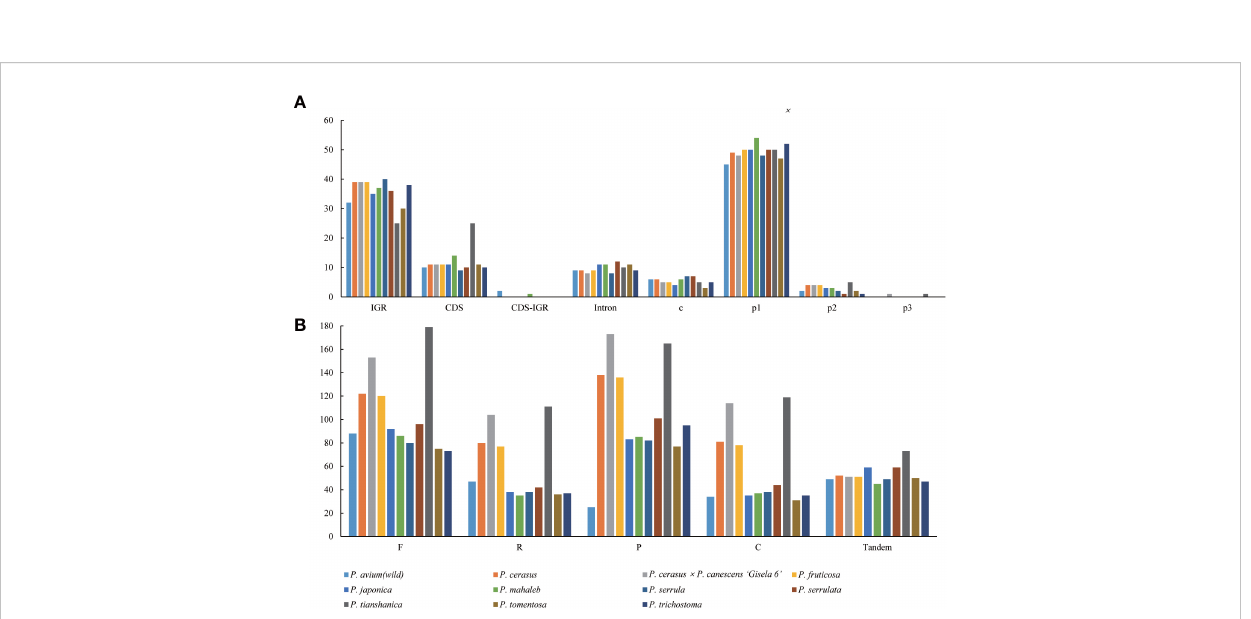
FIGURE 4 Repetitive motif abundance in 11 Cerasus species computed by REPuter and Tandem Repeats Finder. (A) Distribution and types of simple sequence repeats in the eleven chloroplast genomes. (B) Number of repeat types in the eleven chloroplast